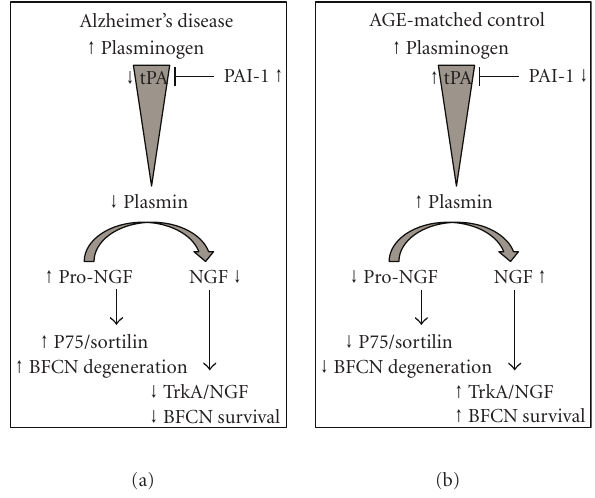
Figure 1: Proposed mechanism of pro-NGF induced neurodegenera- tion in Alzheimer’s disease and age-matched controls. (1) The cleavage of plasminogen to plasmin is altered due to decreased tPA from increased PAI-1 activity, leading to an accumulation of pro-NGF in the hippocampus. (2) Increased pro-NGF leads to a preferential activation of the high a ffi nity p75NTR/sortilin complex. (3) As NGF is down-regulated and pro-NGF is upregulated, high a ffi nity NGF binding to TrkA receptors is compromised. (4) There is a shift in the balance of TrkA and p75NTR at the distal axon of the BFCN. (5) Pro-NGF/p75NTR/sortilin signaling increases JNK signaling and ultimately induces degeneration of the BFCNs. In age- matched controls (normal aging), balanced tPA activity allows for (1) cleavage of pro-NGF to yield NGF and (2) sustained NGF/TrkA signaling to promote cholinergic integrity. Abbreviations: tissue plasminogen activator (tPA), plasminogen activator inhibitor-1 (PAI-1), nerve growth factor (NGF), tropomyosin related kinase A (trkA = high a ffi nity NGF receptor), pan neurotrophin receptor p75NTR (p75NTR = high a ffi nity pro-NGF